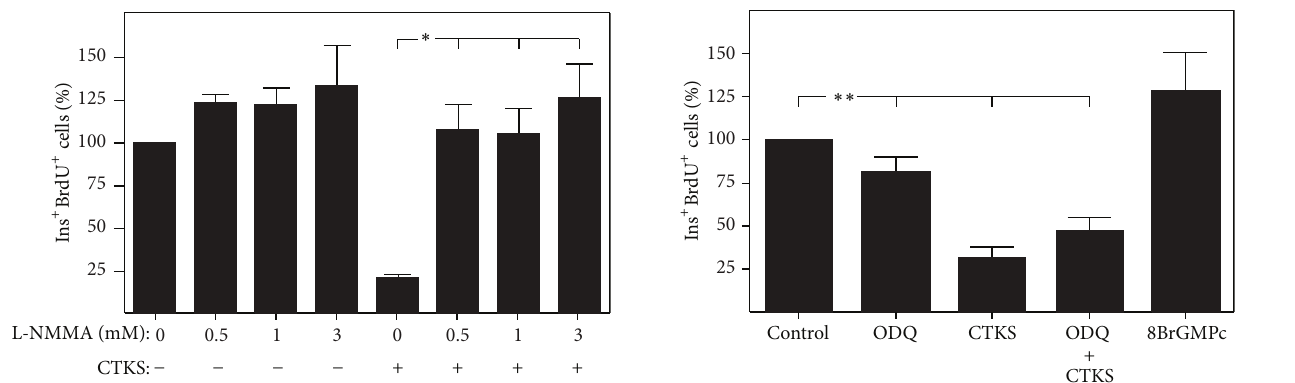
Figure 3: Effect of cGMP pathway alterations in 𝛽 -cell proliferation in response to proinflammatory cytokines. Rat islets were cultured for 48 h in the presence of cGMP pathway activator 8BrGMPc (100 𝜇 M) and a mixture of cytokines IL-1 𝛽 (50 U/mL) + IFN- 𝛾 (1000U/mL) + TNF- 𝛼 (1000U/mL) (CTKS) alone or in combina- tionwithODQ(10 𝜇 M),aninhibitorofguanylatecyclase.Resultsare presented as percentage means ± SEM of combined BrdU/insulin- positive cells relative to insulin positive cells in a minimum of 5 experiments. ∗∗ 𝑃 < 0.01 treated versus